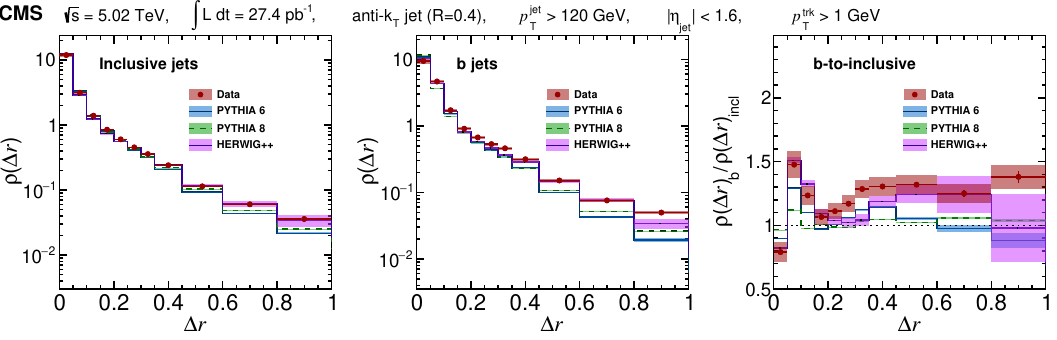
Figure 4 . The jet shape distribution ρ (∆ r ) of inclusive jets (left) and b jets (middle), both with p > 120 GeV and p trk > 1 GeV are presented as functions of ∆ r for data(red markers), the pythia T T 6.426 (blue line) and the pythia 8.230 (green dashed line) simulations. The right plot shows the b -to-inclusive jet shape ratio as functions of ∆ r for data, pythia 6 (blue line) and pythia 8.230 (green dashed line) simulations. The shadowed boxes represent the systematic